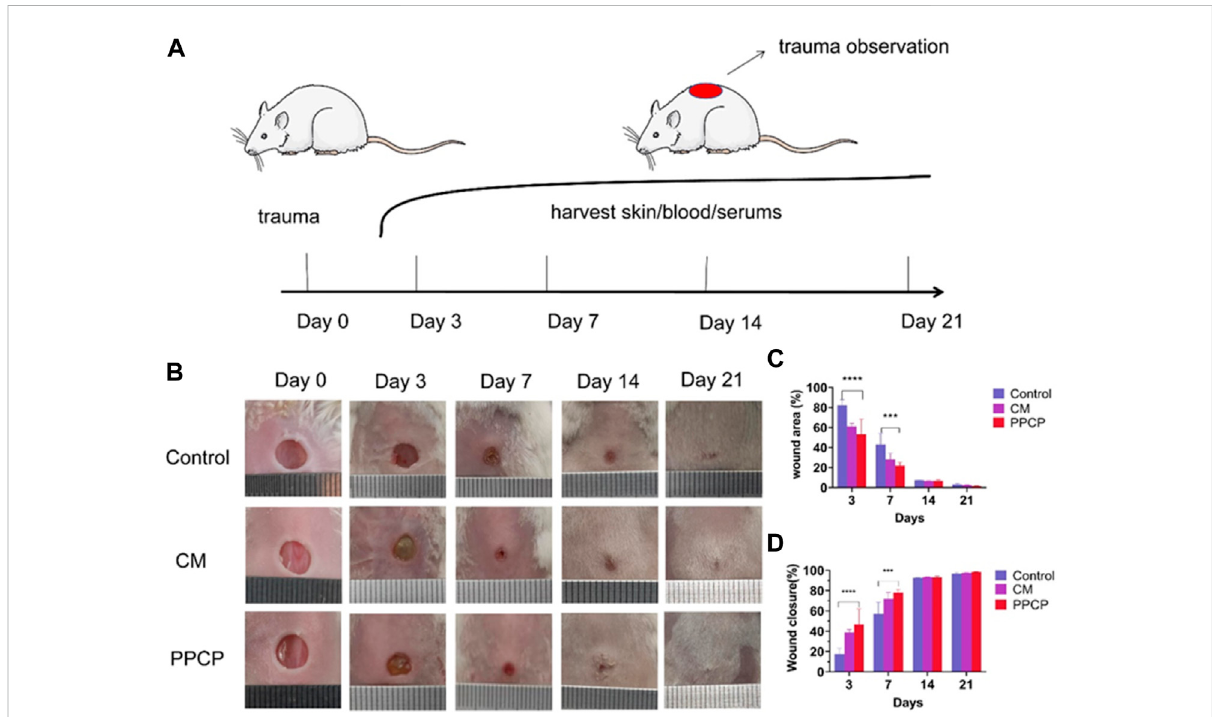
FIGURE 5 Representative pictures and data analysis of various membrane treatments during wound healing. (A) Schematic diagram of the entire in vivo wound healing experiment; (B) Typical images of trauma healing among different therapy groups on the speci fi ed number of days; (C) Analysis of speci fi c data on wound area at different times of treatment; (D) Analysis of speci fi c data on the area of trauma healing after the speci fi ed treatment time. (Mean ± SD, n = 3, *** p < 0.001, **** p <